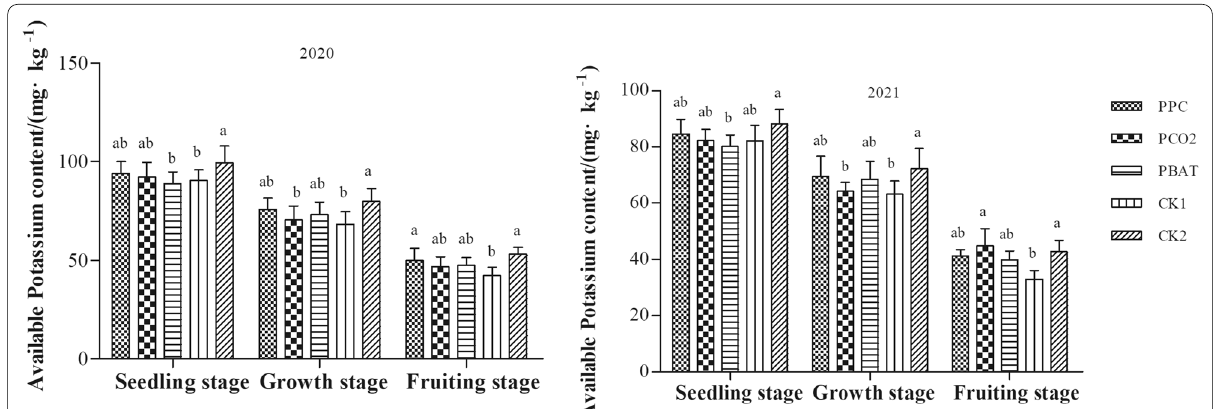
Fig. 3 Available Potassium content in soil of different mulching treatment. Different lowercase letters indicate significant difference between treatments (P < 0. 05)